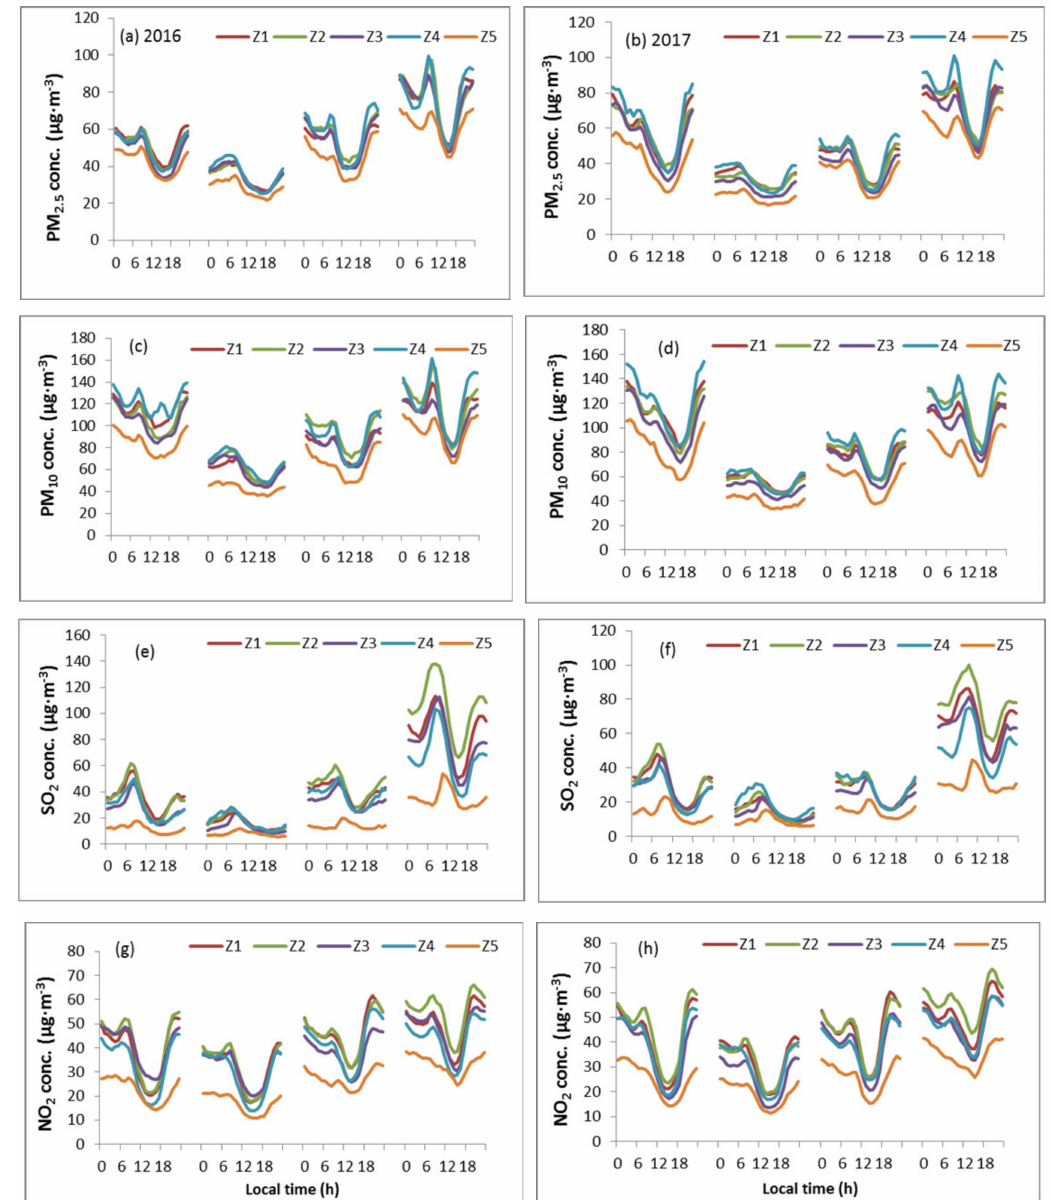
Figure 4. Hourly and season variation in concentrations of ( a ) PM 2.5 in 2016, ( b ) PM 2.5 in 2017, ( c ) PM 10 in 2016, ( d ) PM 10 in 2017, ( e ) SO 2 in 2016, ( f ) SO 2 in 2017, ( g ) NO 2 in 2016, and ( h ) NO 2 in 2017 across four seasons and five ecological functional zones in Shenyang from January 2016 to December